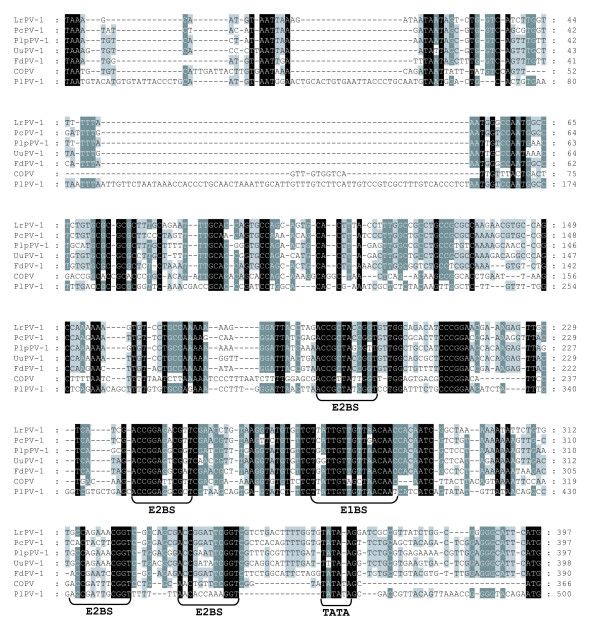
URR alignment of the λ-PVs. Nucleotide sequence alignment of the upstream regulatory region (URR) or noncoding region (NCR1), from the stop codon of L1 to the start codon of E6, including the feline papillomaviruses (PVs) Felis domesticus PV type 1 (FdPV1), Lynx rufus PV type 1 (LrPV1), Puma concolor PV type 1 (PcPV1), Panthera leo persica PV type 1 (PlpPV1), and Uncia uncia PV type 1 (UuPV1), and the nonfeline carnivore PVs canine oral PV (COPV) and Procyon lotor PV type 1 (PlPV1), all of which belong to the genus λ-PV. Nucleotides are shaded according to the degree of conservation (black = 100% conserved; dark gray = 80% to 99% conserved; light gray = 60% to 79% conserved; no shade = <60% conserved). The conserved and putative E2 binding sites (E2BSs) and the E1 binding site (E1BS) are indicated. In LrPV-1, an E1BS is located at nucleotides 8,151-8,167, flanked by two conserved E2BSs at nucleotides 8,068-8,079 and 8,215-8,226. Two additional modified putative E2BSs were identified at nucleotides 8,117-8,128 (ACC-N6-GTT) and 8,195-8,206 (GCC-N6-GGT). The E1BS in PcPV-1 is located at nucleotides 8,226-8,242, surrounded by conserved E2BSs at nucleotides 8,143-8,154 and 8,289-8,300, and putative modified E2BSs at nucleotides 8,193-8,204 (ACC-N6-GTT) and 8,269-8,280 (CAC-N6-GGT). In PlpPV-1 we identified an E1BS at nucleotide 8,091-4, two conserved E2BSs at nucleotides 8,057-8,068 and 52-63, and modified putative E2BS motifs at nucleotides 8,007-8,018 (ACC-N6-GTT; a position where all other sequences in the alignment exhibited a conserved E2BS) and at nucleotides 32-43 (GCC-N6-GGT). The E1BS in UuPV-1 is located at nucleotides 7,983-7,999, with three conserved E2BSs at nucleotides 7,899-7,910, 7,949-7,960 and 8,047-8,058, and a putative modified E2BS (GCC-N6-GGT) at nucleotides 8,027-8,038. The TATA box of the E6 promotor in LrPV-1, PcPV-1, PlpPV-1, FdPV-1, COPV, and PlPV-1, and a possible degenerate TATA box (TTTAA) in UuPV-1 is indicated.